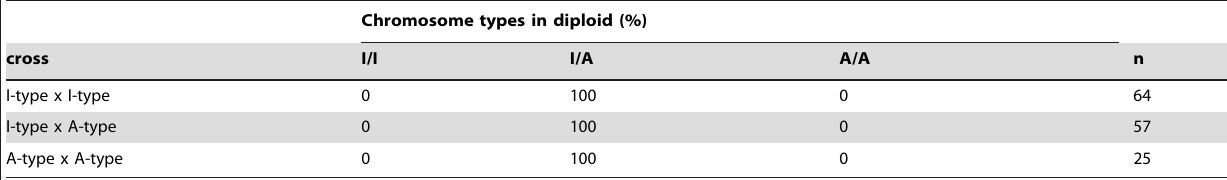
Table 1. Chromosome type in diploid